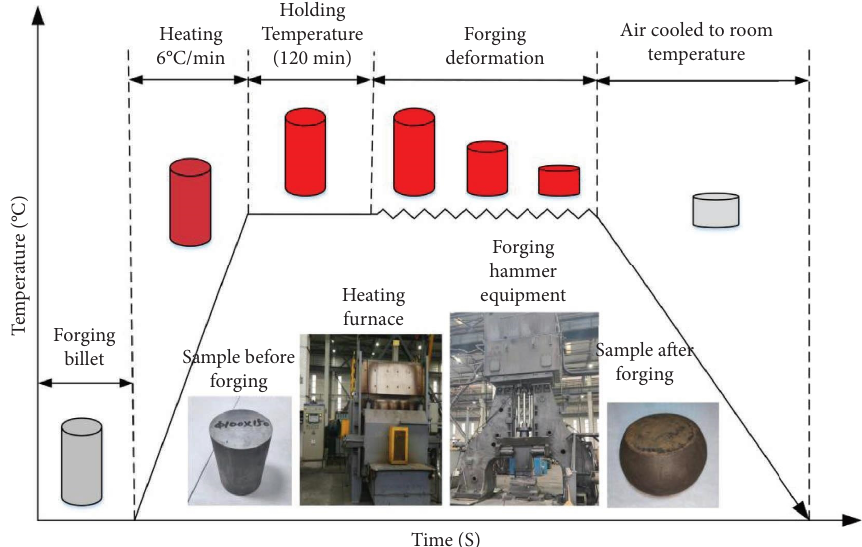
Figure 1: Ti-6Al-4V alloy forging process. Table 2: Forging experiment scheme of Ti-6Al-4V alloy at diferent forging temperatures. Samples